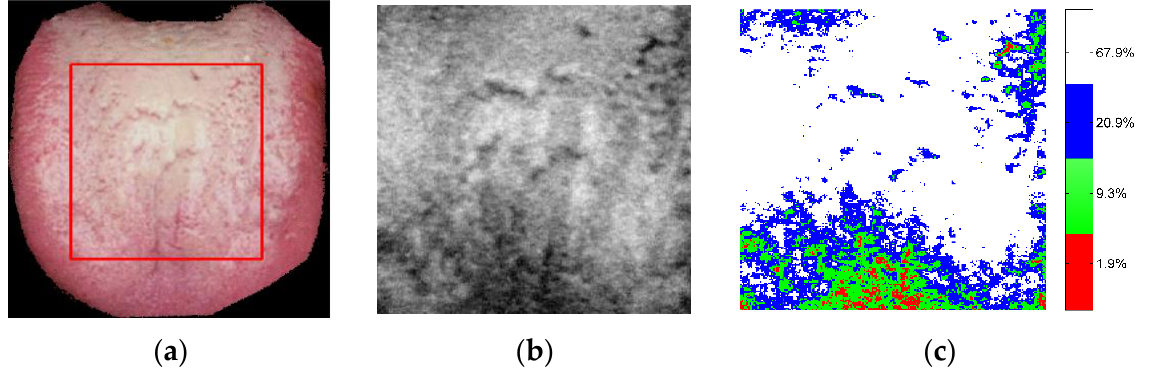
Figure 9. SAM images of fur region (the middle area of the tongue within red lines). ( a ) Tongue image of Sample 2. ( b ) SAM image of the middle region compared to the tongue body spectra. ( c ) SAM image divided into 4 parts by the radian value—the white region has larger SAM values which can be regarded as the tongue fur.